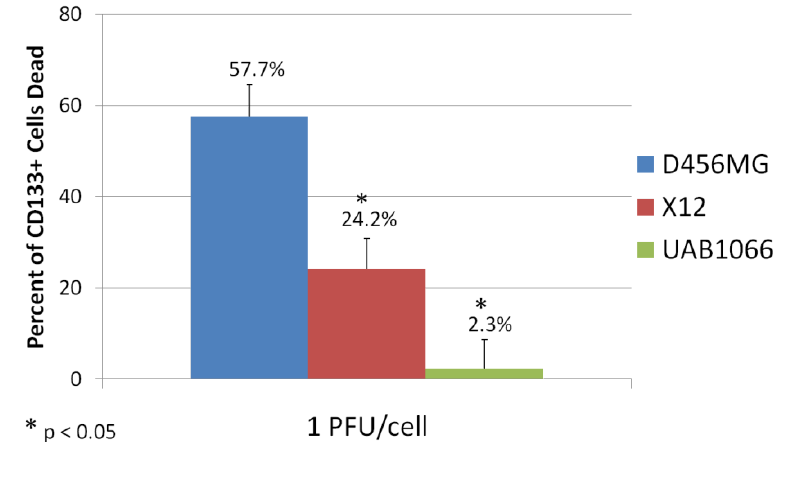
Figure 4. The CD133+ glioma stem cells in the pediatric GBM xenograft D456MG were significantly more sensitive to killing than several adult GBM xenografts tested after 72 hours of low dose infection (1 plaque-forming unit (PFU) per cell) with G207, an engineered herpes simplex virus used in adult GBM trials at the University of Alabama at